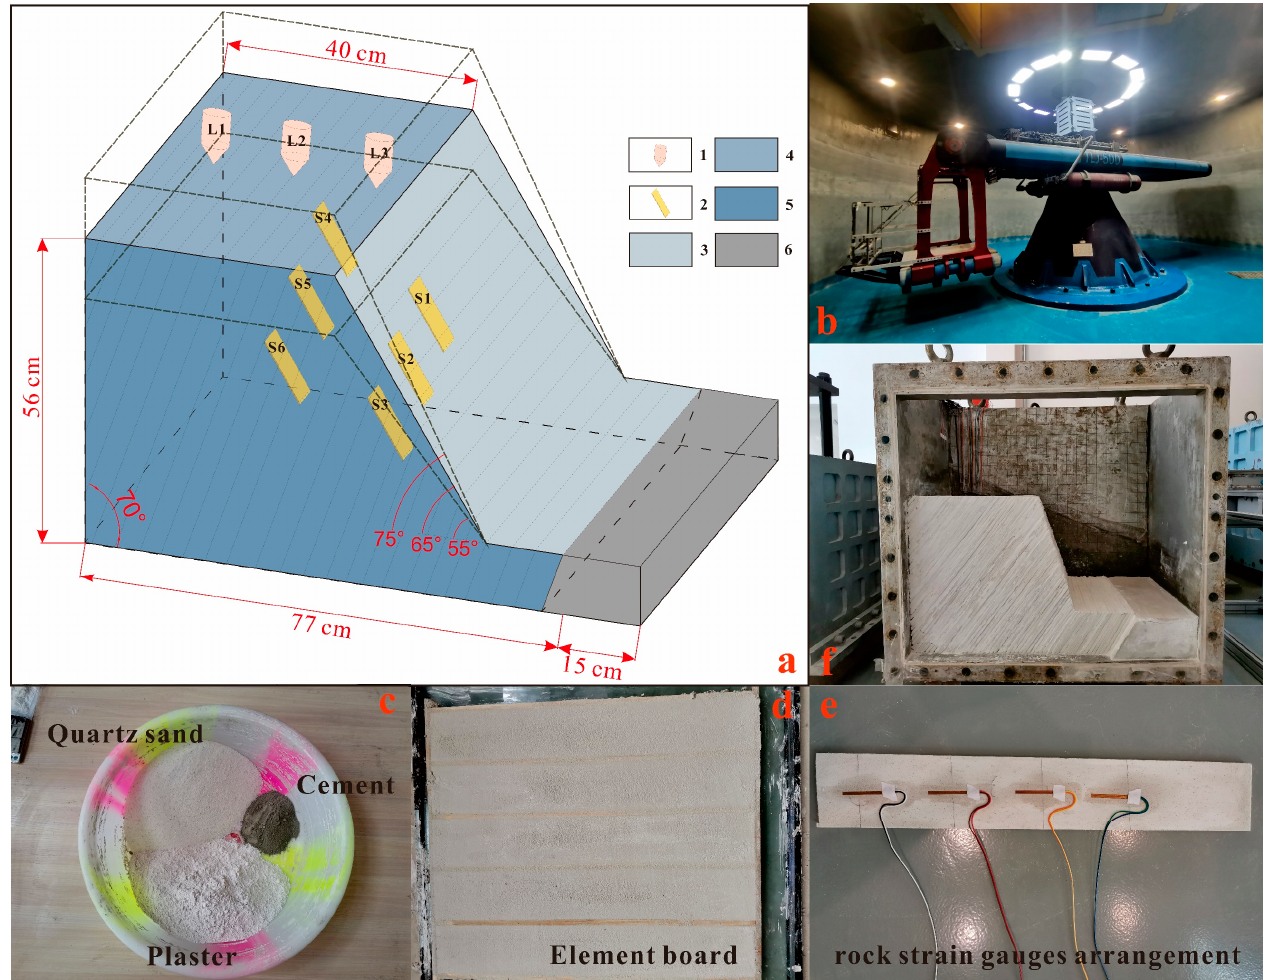
Figure 4. ( a ) Figure of the model designs, 1 linear variable differential transformer to obtain the displacement, 2 rock strain gauges, 3 free face of slope, 4 slope crest, 5 plate beam structure, 6 fixed. structure, ( b ) TLJ-500 geotechnical centrifuge, ( c ) similar material, ( d ) element board, ( e ) rock strain gauges arrangement, ( f ) similitude model.